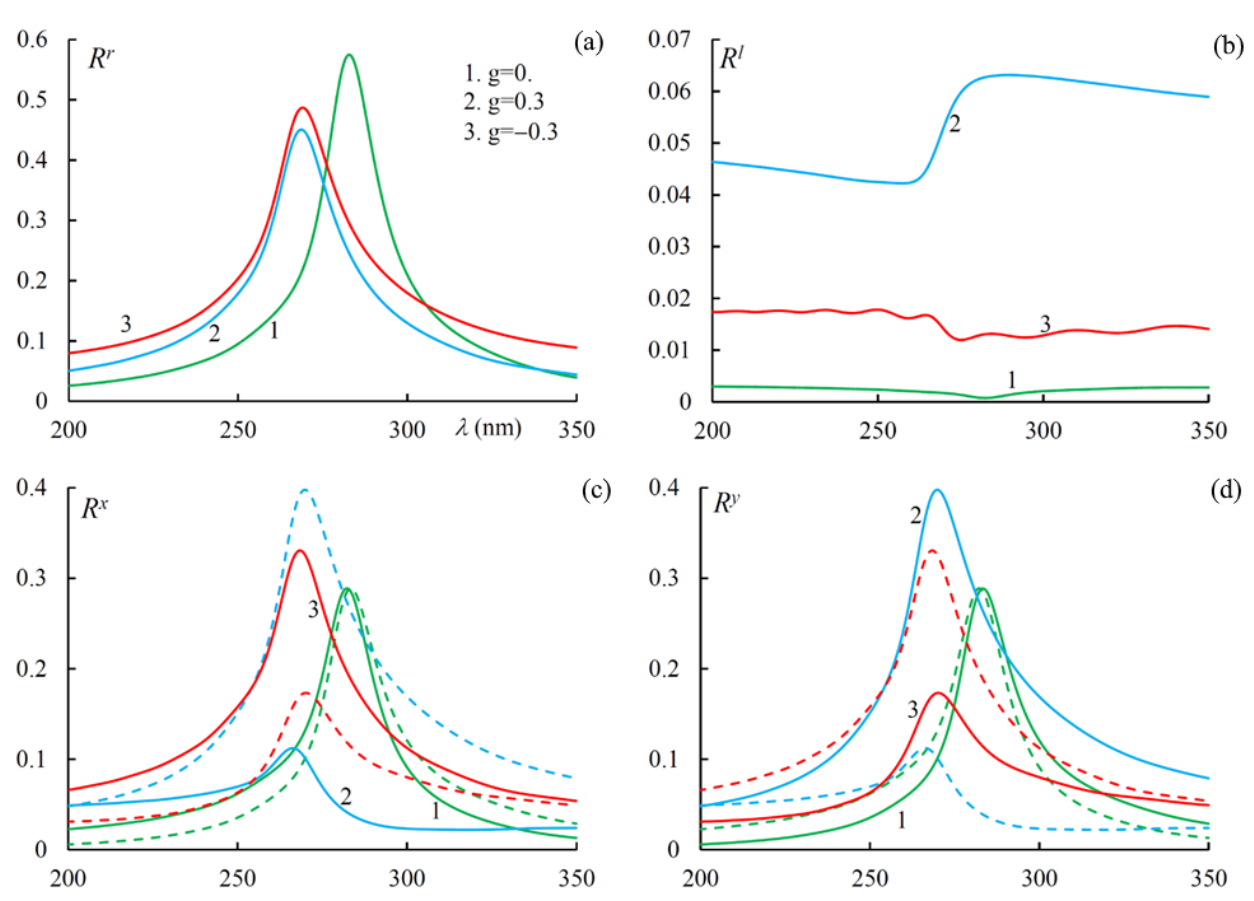
Figure 3. The reflection spectra at different values of g . The incident light has ( a ) right circular, ( b ) left circular, ( c ) linear along the x axis, and ( d ) linear along the y axis polarizations. Solid lines correspond to Im𝜀 1 = 0.2 , Im𝜀 2 = 0 , and dashed lines to Im𝜀 1 = 0.2 , Im𝜀 2 = 0 .